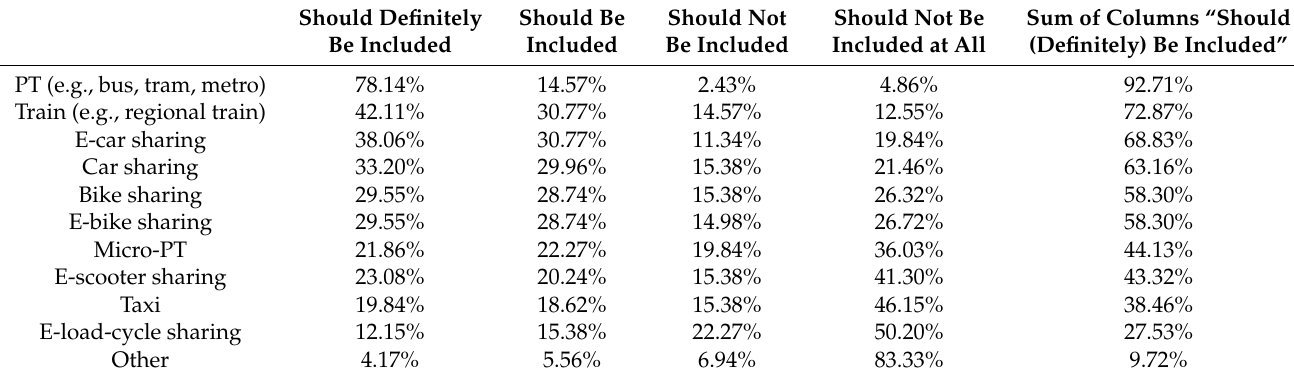
Table 6. Results for direct question on preferred transport modes to be included in MaaS